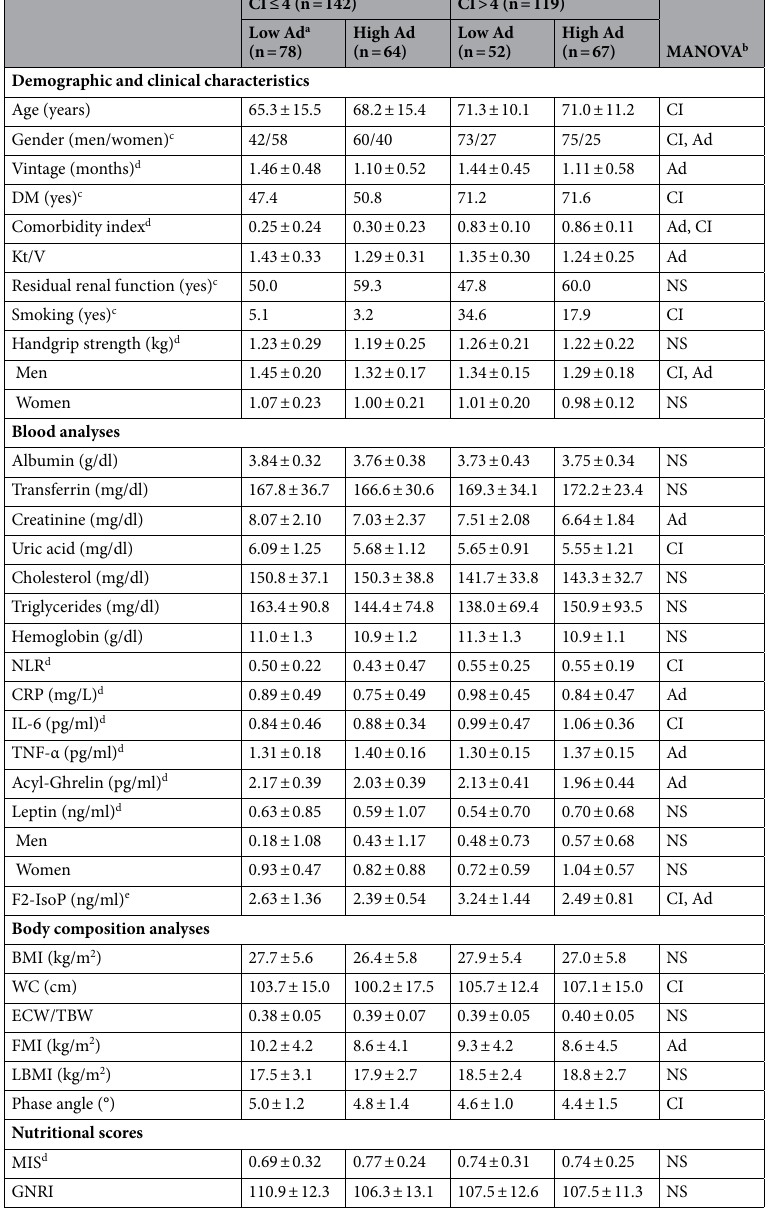
Table 1. Demographic, clinical and biochemical characteristics of the study population (n = 261), grouped according to comorbidity index and serum adiponectin (mcg/ml) levels. CI, comorbidity index; NS, non- significant; Ad, adiponectin; DM, diabetes mellitus; NLR, neutrophil to lymphocyte ratio; CRP, C-reactive protein; TNF-α, tumor necrosis factor α; IL-6, interleukin-6; F 2 -IsoP, F 2 -isoprostanes; BMI, body mass index; WC, waist circumference; ECW/TBW, extra-cellular water to total body water ratio; FMI, fat mass index; LBMI, lean body mass index; MIS, malnutrition-inflammation score; GNRI, geriatric nutritional risk index. a Low adiponectin was defined as adiponectin < 8.28 mcg/ml, the value below the median of distribution. b Two- factor MANOVA. Significant ( p < 0.05) effects are given for comorbidity index (CI), adiponectin (Ad), and the interaction of comorbidity index with adiponectin (CI × Ad). c Assessed by χ 2 test. d Continuous variables that did not follow a normal distribution (dialysis vintage, comorbidity index, handgrip strength, TNF-α, CRP, IL-6, acyl-ghrelin, leptin and MIS) were log-transformed before their insertion into this model. e F2-IsoP levels were randomly measured in 233